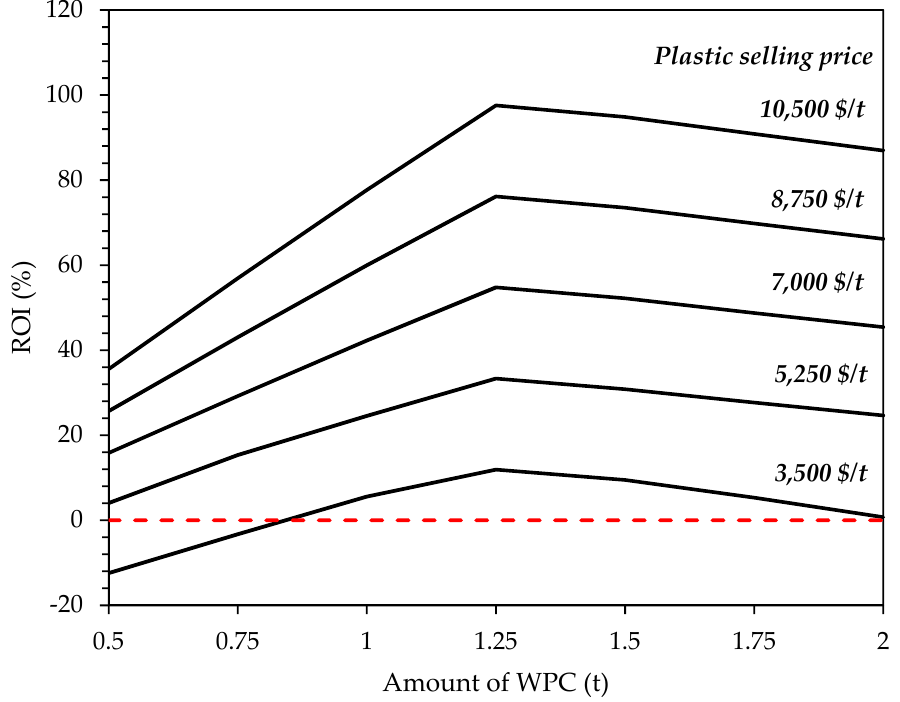
Figure 8. E ff ects of changing amount of WPC at di ff erent plastic selling prices on the ROI (%). Red dashed line represents ROI at Figure 8. Effects of changing amount of WPC at different plastic selling prices on the ROI (%). Red dashed line represents ROI at 0%.